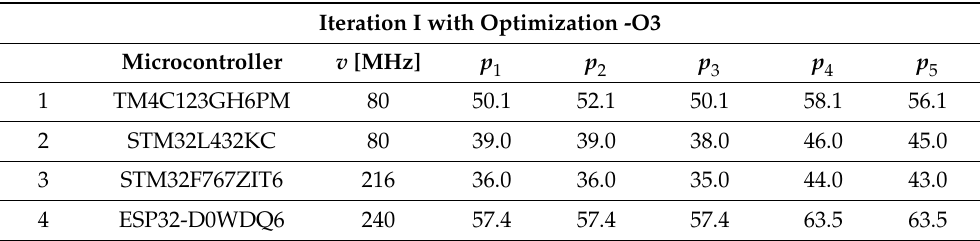
Table 4. The results of algorithm performance on different microcontrollers for Iteration I.